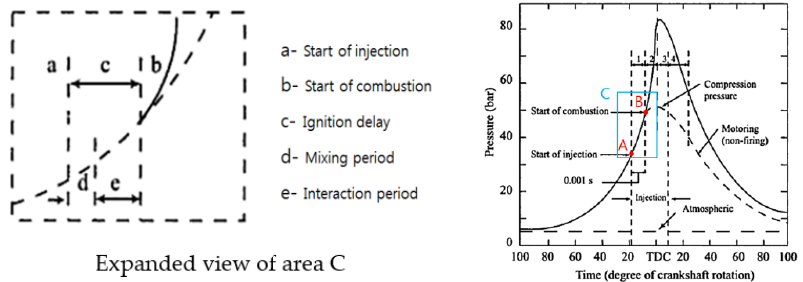
Figure 2. Stages of combustion in compression ignition (CI) engines.